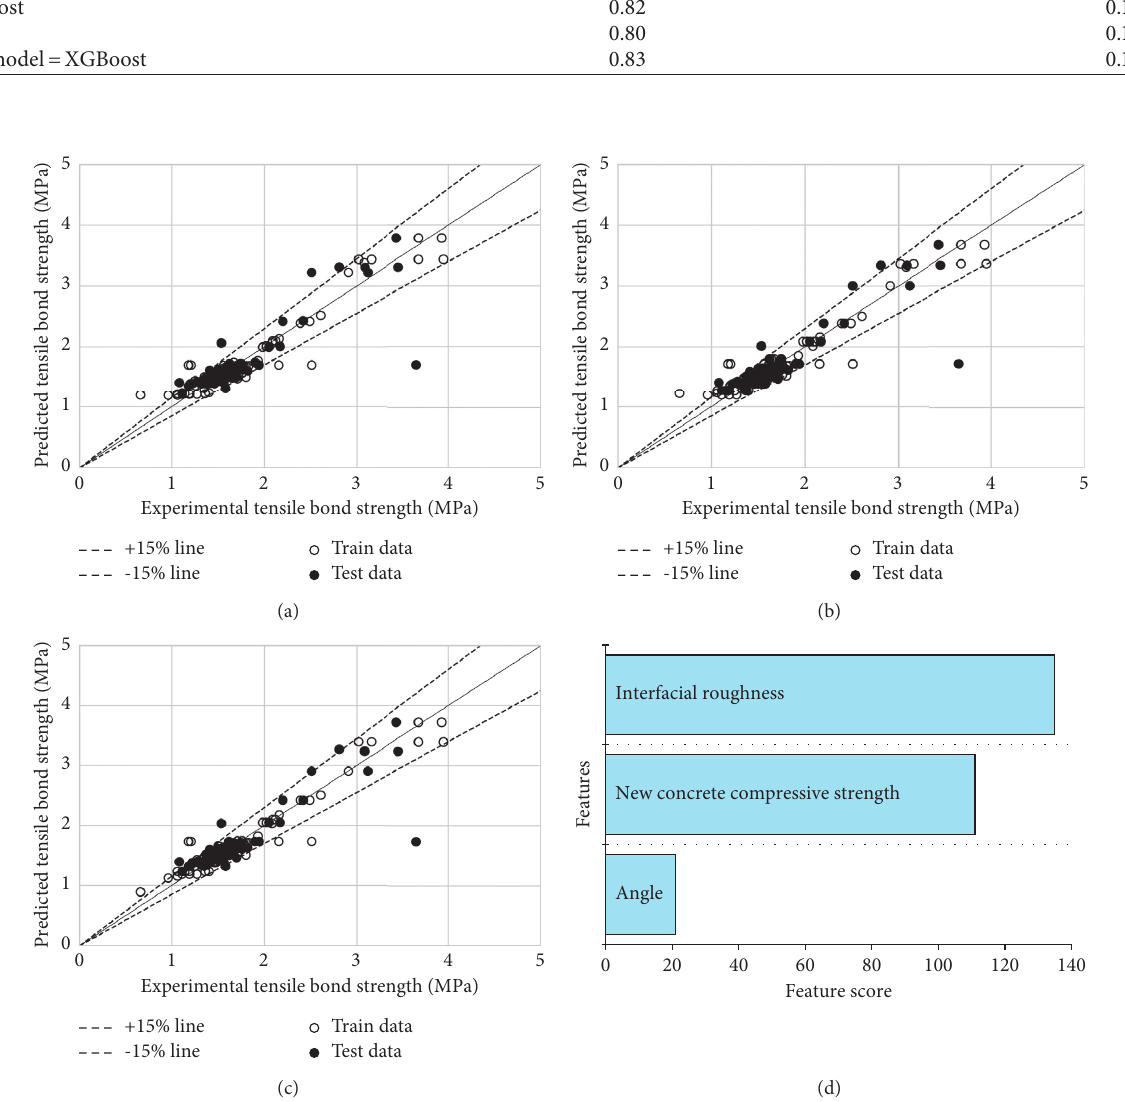
Figure 16: Predicted performance. (a) Random Forest model. (b) Gradient boosting model. (c) XGBoost model. (d) Feature